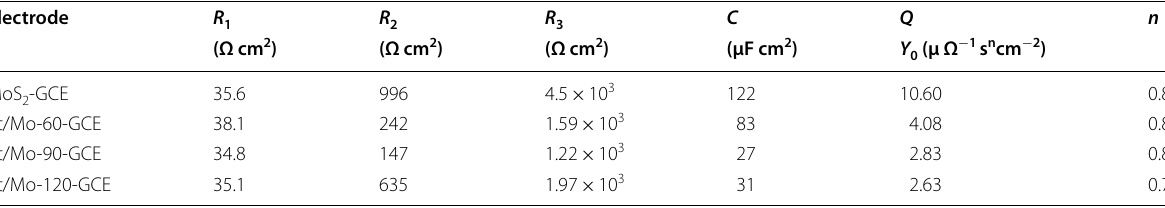
Table 2 Electrochemical parameters achieved from the simulation of the EIS results Electrode